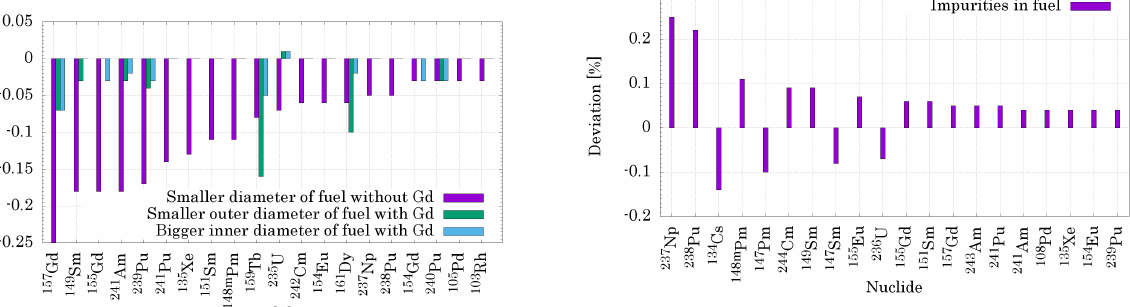
Figure 12. Effect of impurities in the